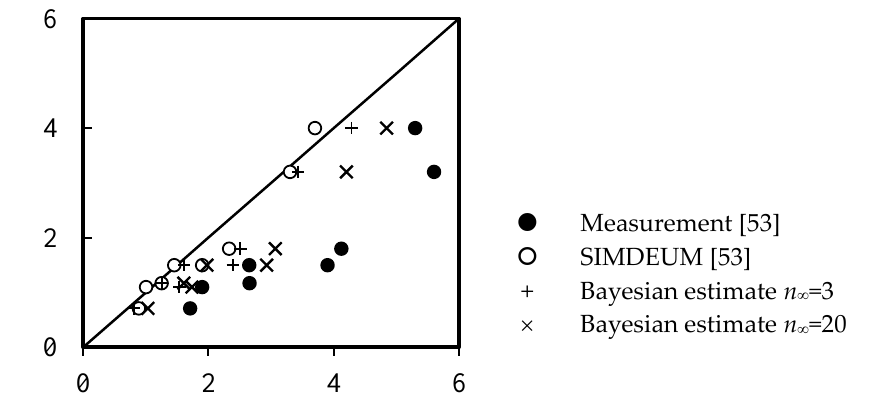
Figure 8. Design flow rates for offices, business hotels, and nursing homes. x -axis: design flow rate q s (L · s − 1 ). y -axis: measured maximum flow rate q m (L · s − 1 ).